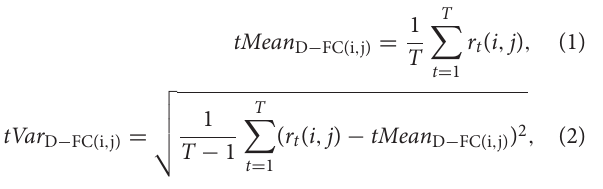
Frontiers in Human Neuroscience |